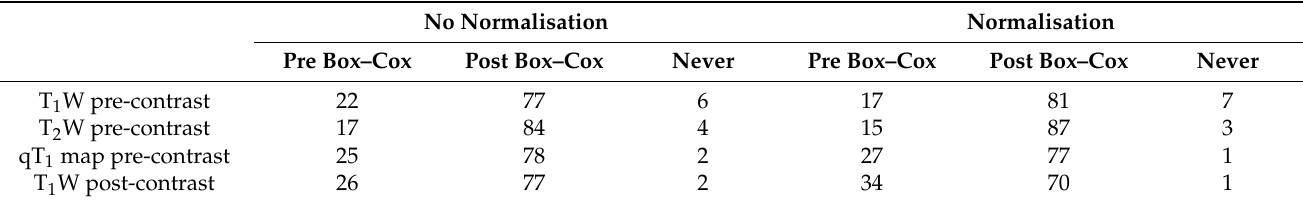
Table 1. Effectiveness of Box–Cox transformations, assessed by the number of features with distributions consistent with a Gaussian distribution in different scenarios, for four MR sequences (rows), without and with normalisation (left and right). The first, second, and third column on each side show the number of features whose original distribution was Gaussian (Pre Box–Cox), the number of features whose original non-Gaussian distribution was transformed to Gaussian (Post Box–Cox), and the number of features whose distribution was non-Gaussian before and after applying transformations (Never). In all cases the total is 105, reflecting the number of features